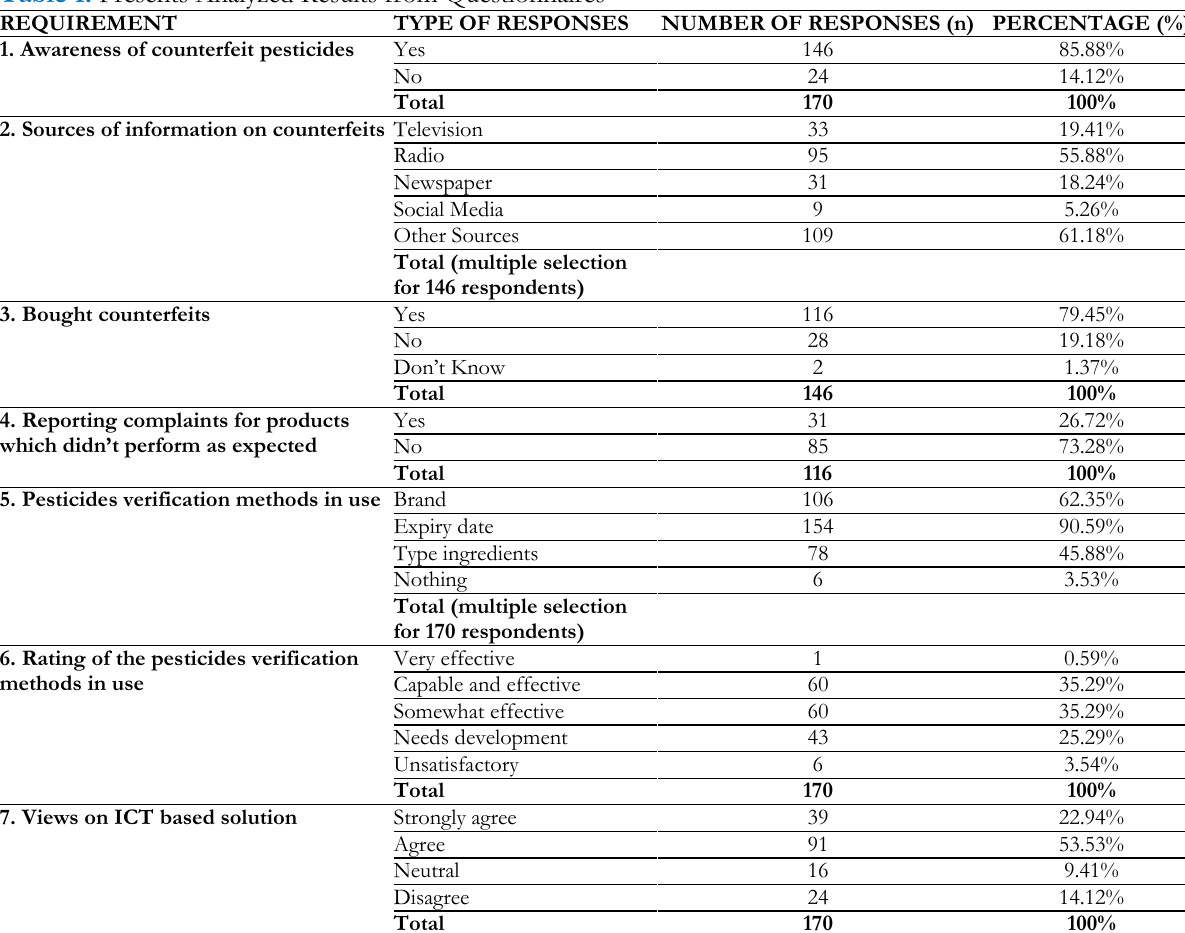
Table 1. Presents Analyzed Results from Questionnaires